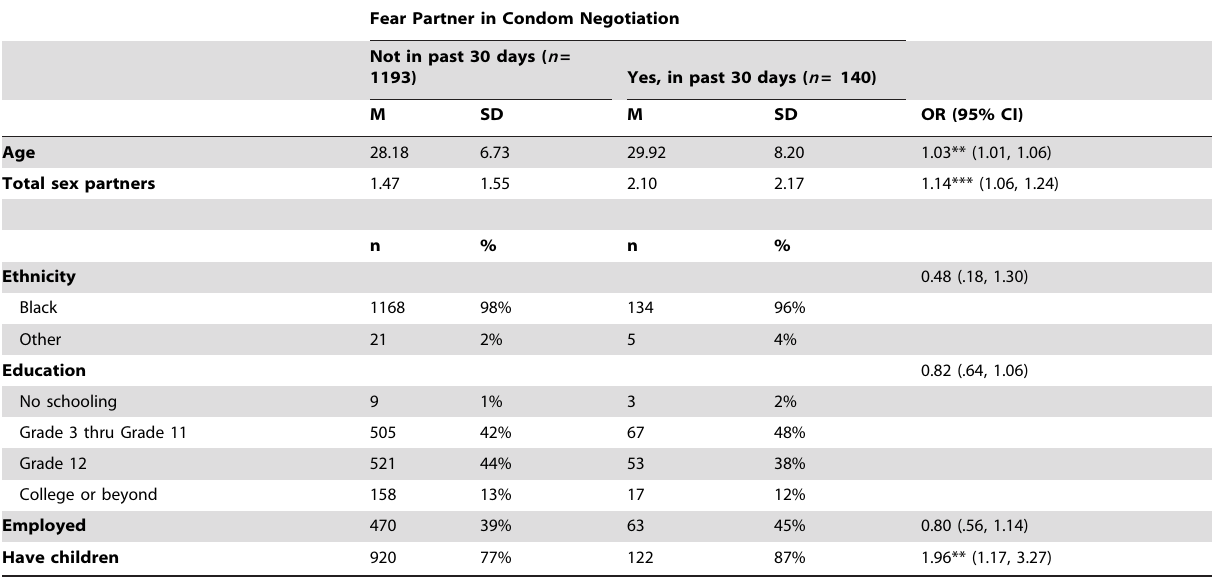
Table 1. Demographics by fear of partner in condom negotiation ( n = 1333).